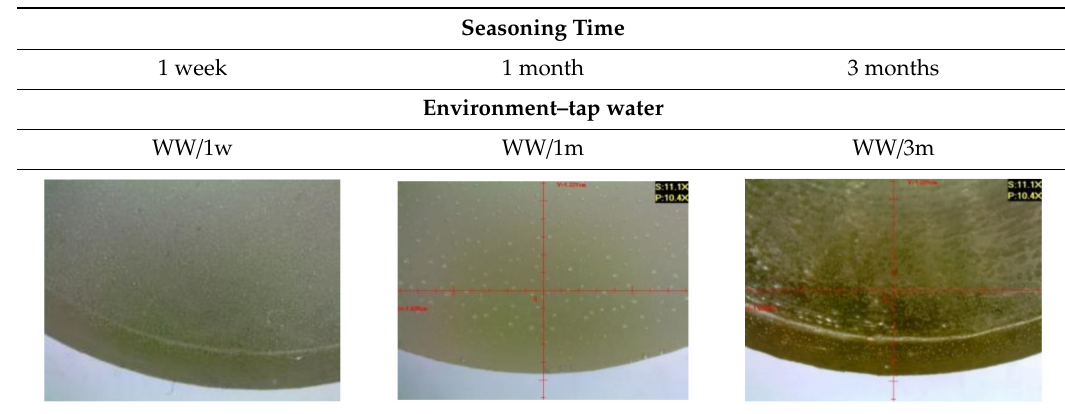
Table 5. Microscopic images of the unmodified epoxy compound seasoned in exploitation environments (10 ×